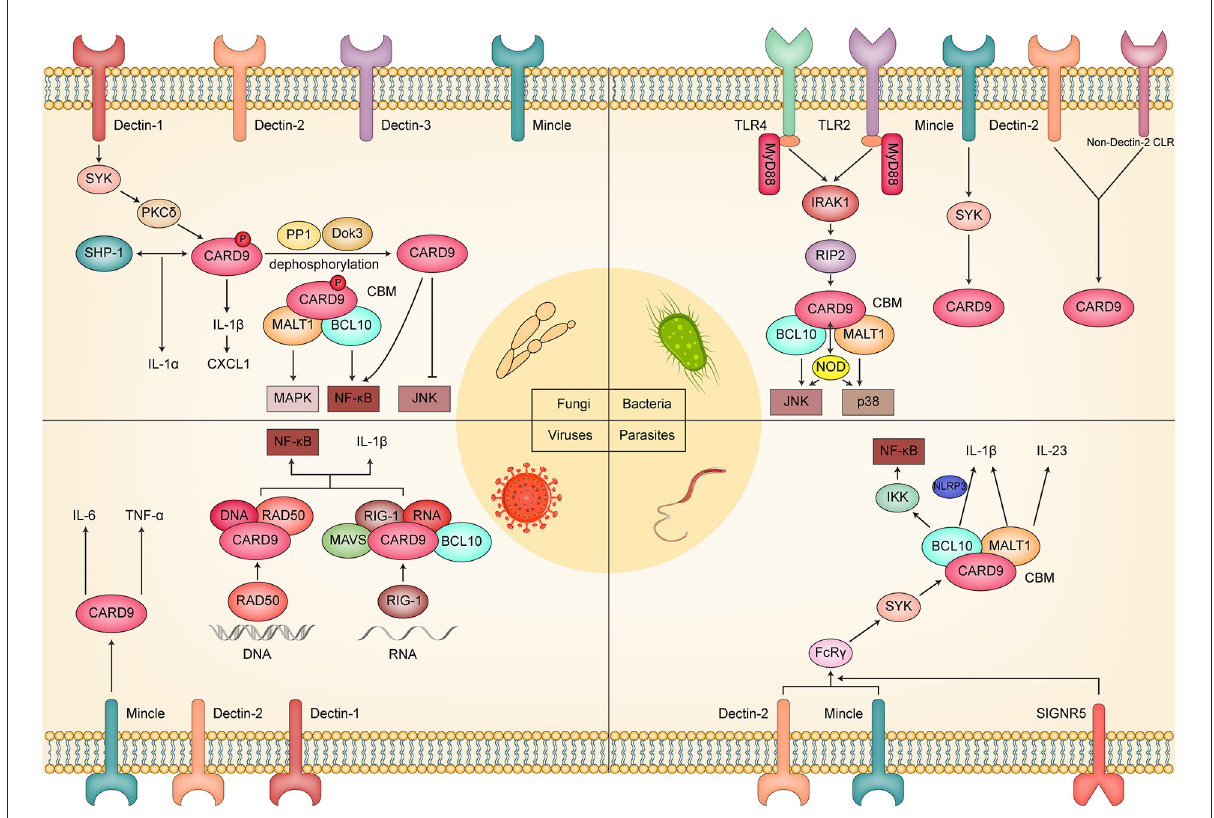
FIGURE2 Schematic diagram of the molecular mechanism by which CARD9 plays a critical role in fungal, bacterial, viral, and parasitic